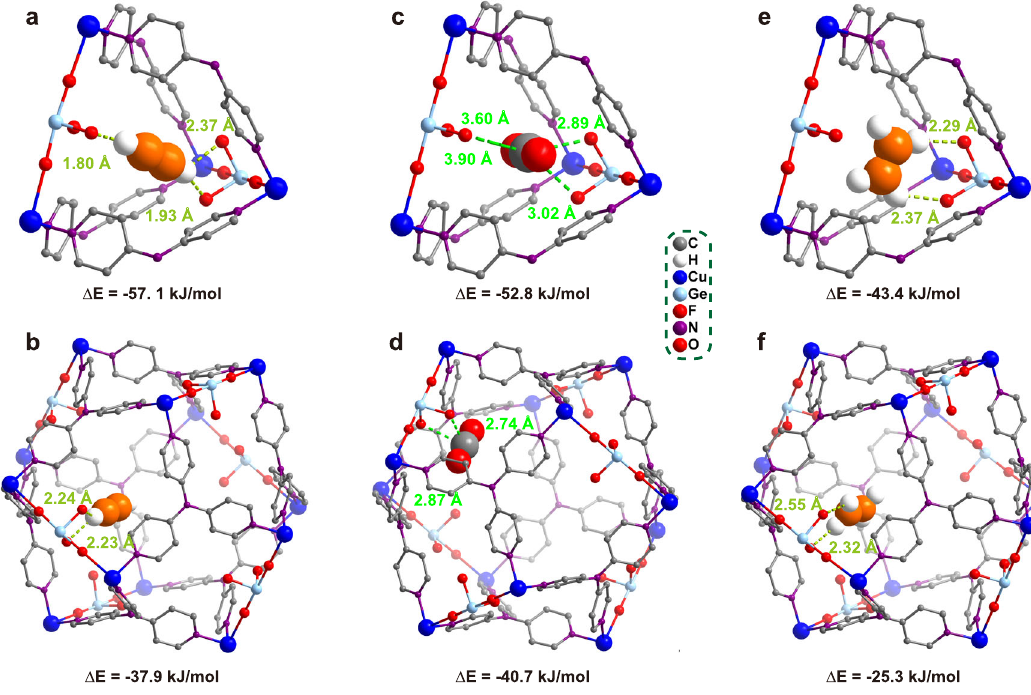
Fig. 3 | The DFT optimized gas adsorption con fi guration. Binding sites I, II of C 2 H 2 ( a, b ), CO 2 ( c, d ), and C 2 H 4 ( e, f